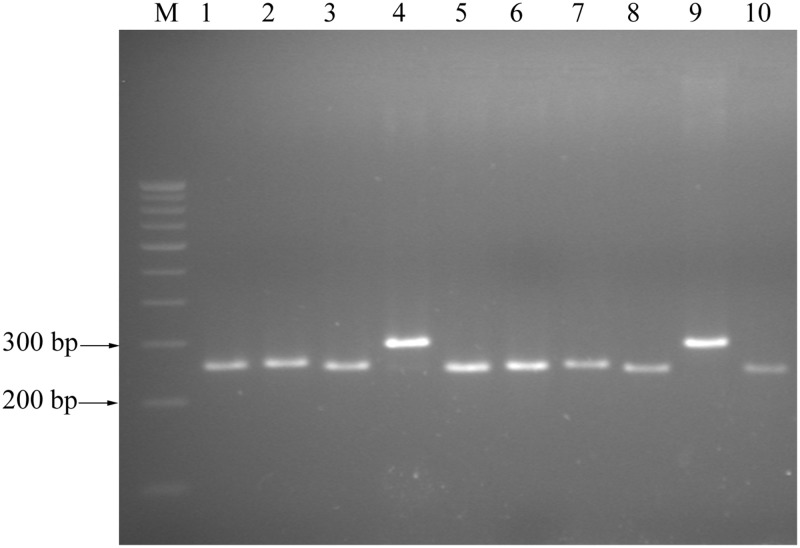
PCR amplification of black gram genic-SSR marker VMgSSR-78 in related Vigna species.